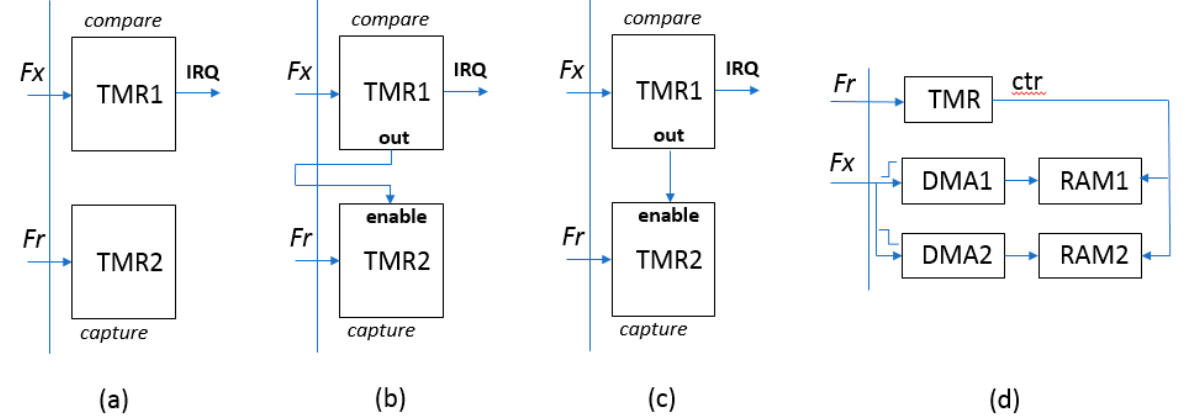
Figure 3. Measuring frequency using built ‐ in timers (( a )—unlinked timers, ( b )—externally linked timers, ( c )—internally linked timers, ( d )—timer in the DMA timers, ( c )—internally linked timers, ( d )—timer in the DMA mode.)